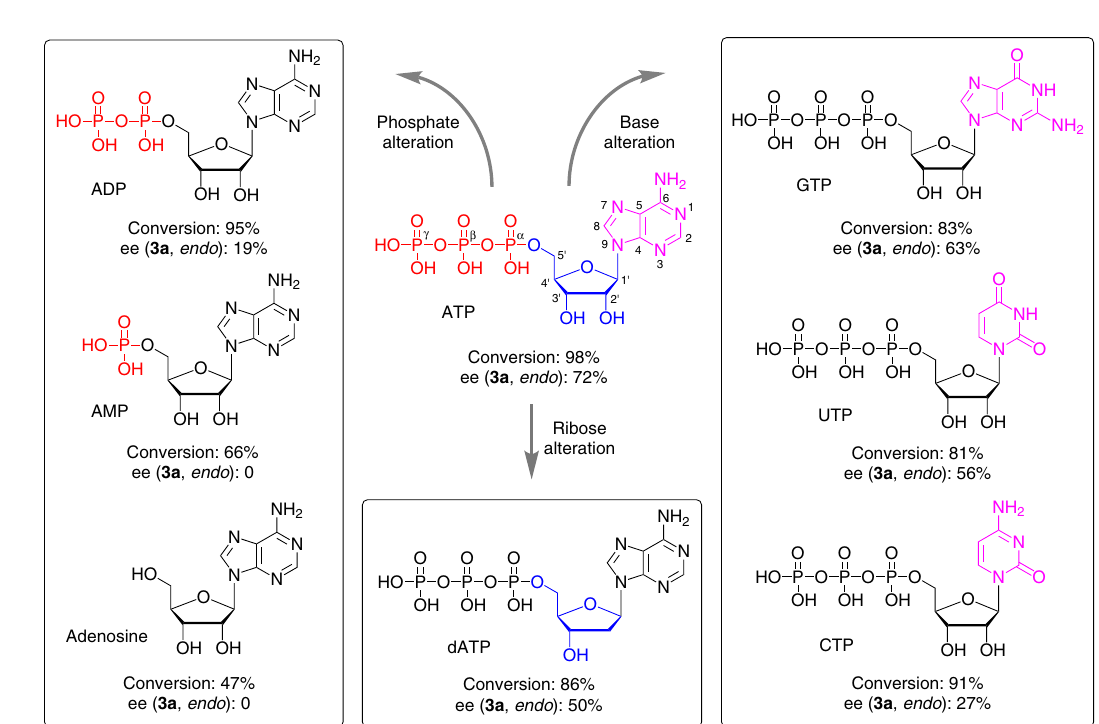
Fig. 2 The effect of ATP analogues for the Cu 2 + ·ATP-catalysed Diels – Alder reaction. Reaction conditions: 1a (1 mM), 2 (200 mM), ATP analogue (250 μ M), Cu(OTf) 2 (50 μ M), MES buffer (20 mM, pH 5.5), 4 °C, 24 h. All data are the averages of at least two individual experiments (reproducibility: ±5% conversion, ±3%